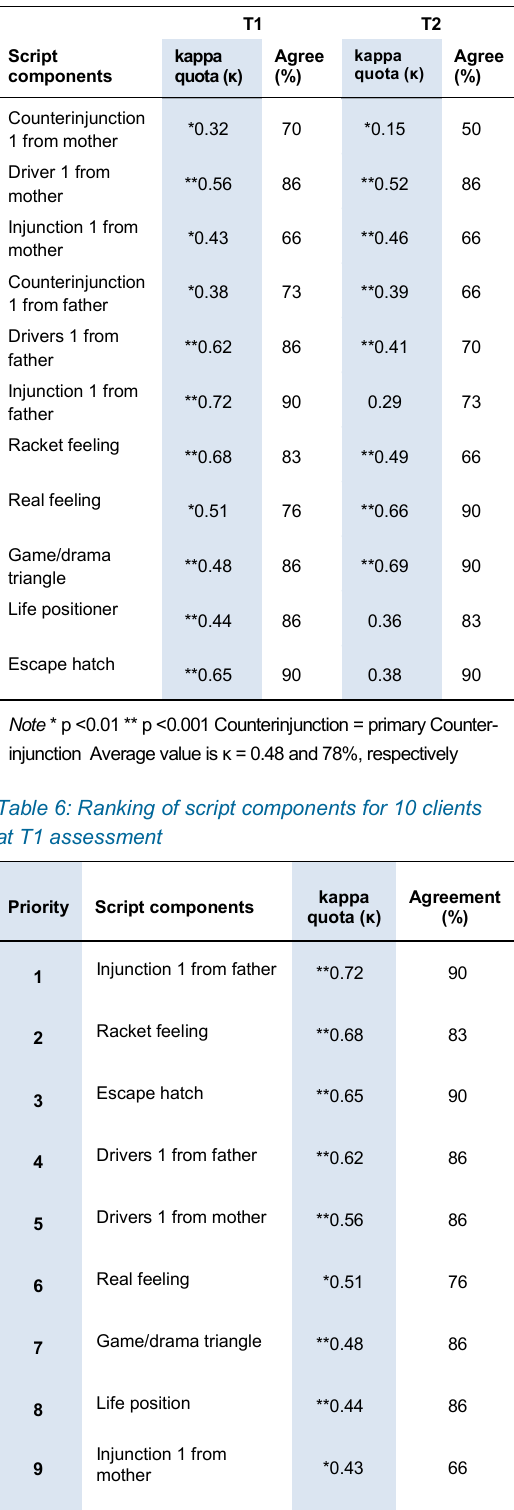
Table 4: kappa ratio and percentage agreement between